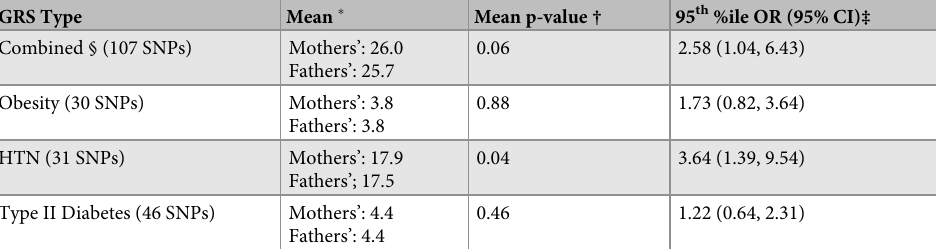
Table 4. Sub-analysis in trios with a child with tetralogy of Fallot. Comparison of mothers’ versus fathers’ genetic risk scores (GRS) for adult